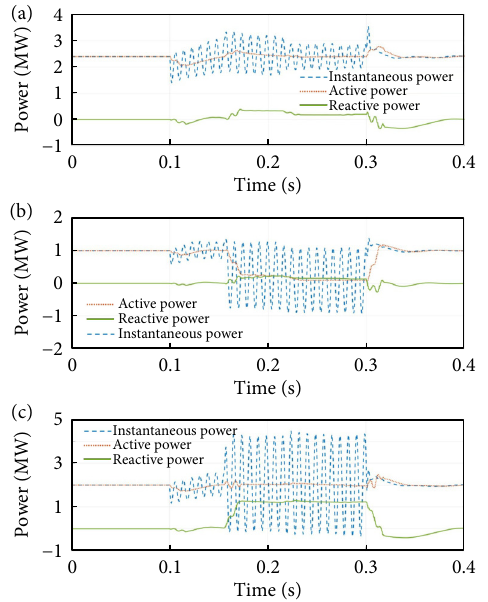
Fig. 10 Results for single-phase-to-ground faults with optimization-based AFM. The power output of ( a ) microgrid 1, ( b ) microgrid 2, and ( c ) microgrid 3, including instantaneous power, active power, and reactive power.